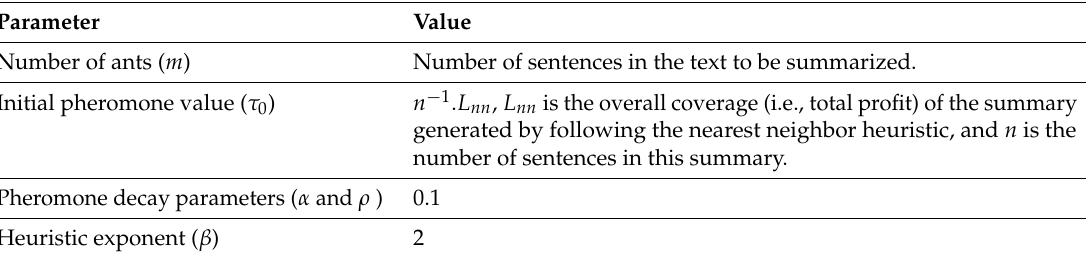
Table 1. ACS parameter